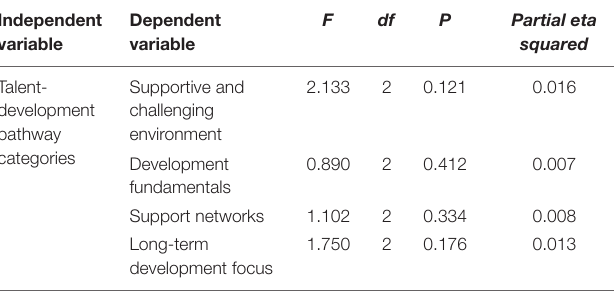
TABLE 5 | Multivariate analysis of variance results for developmental phase and aspects related to talent development environment. Independent variable